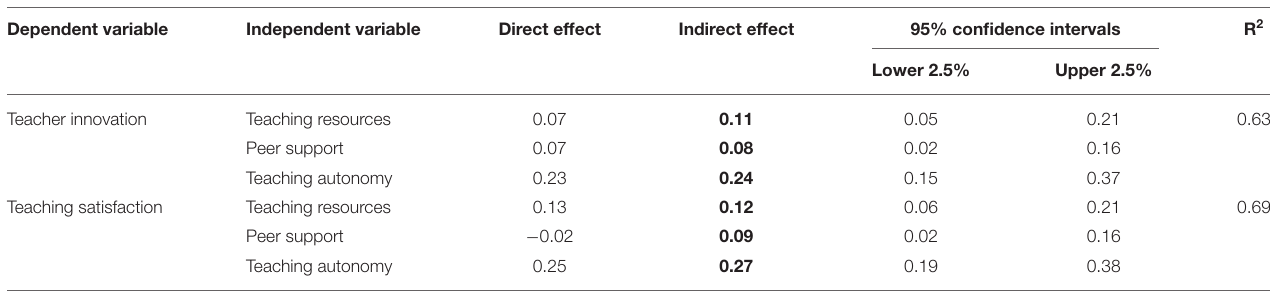
TABLE 3 | The estimate of direct and indirect effects of the 95% confidence intervals. Dependent